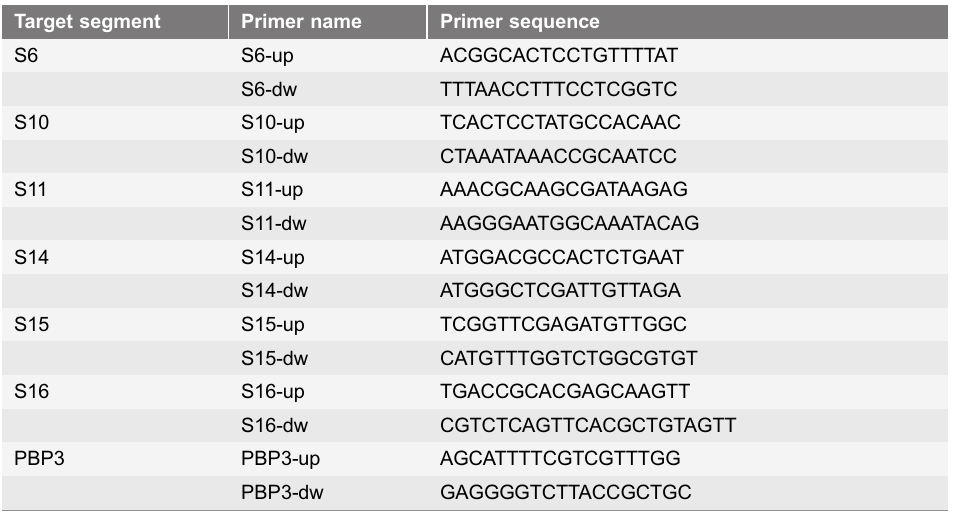
Table 1. Primers used in this